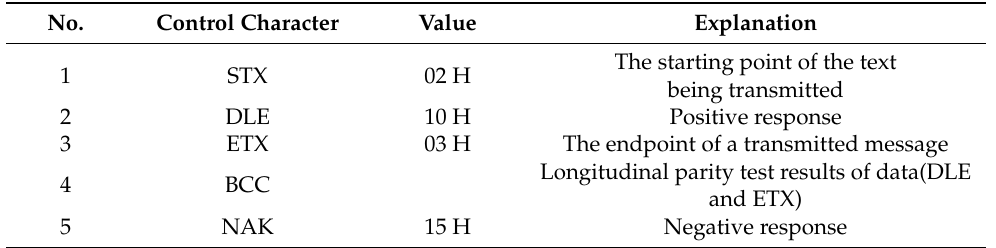
Table 1. Basic control character description of